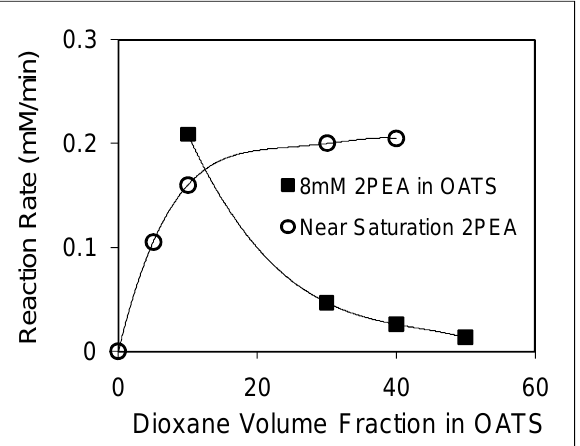
Figure 8. Monophasic Ester Hydrolysis Reaction Rates for 8mM (+) and Near-Saturation (O) of 2PEA Solutions as a Function of 1,4-dioxane Fraction in dioxane/H temperature [30].